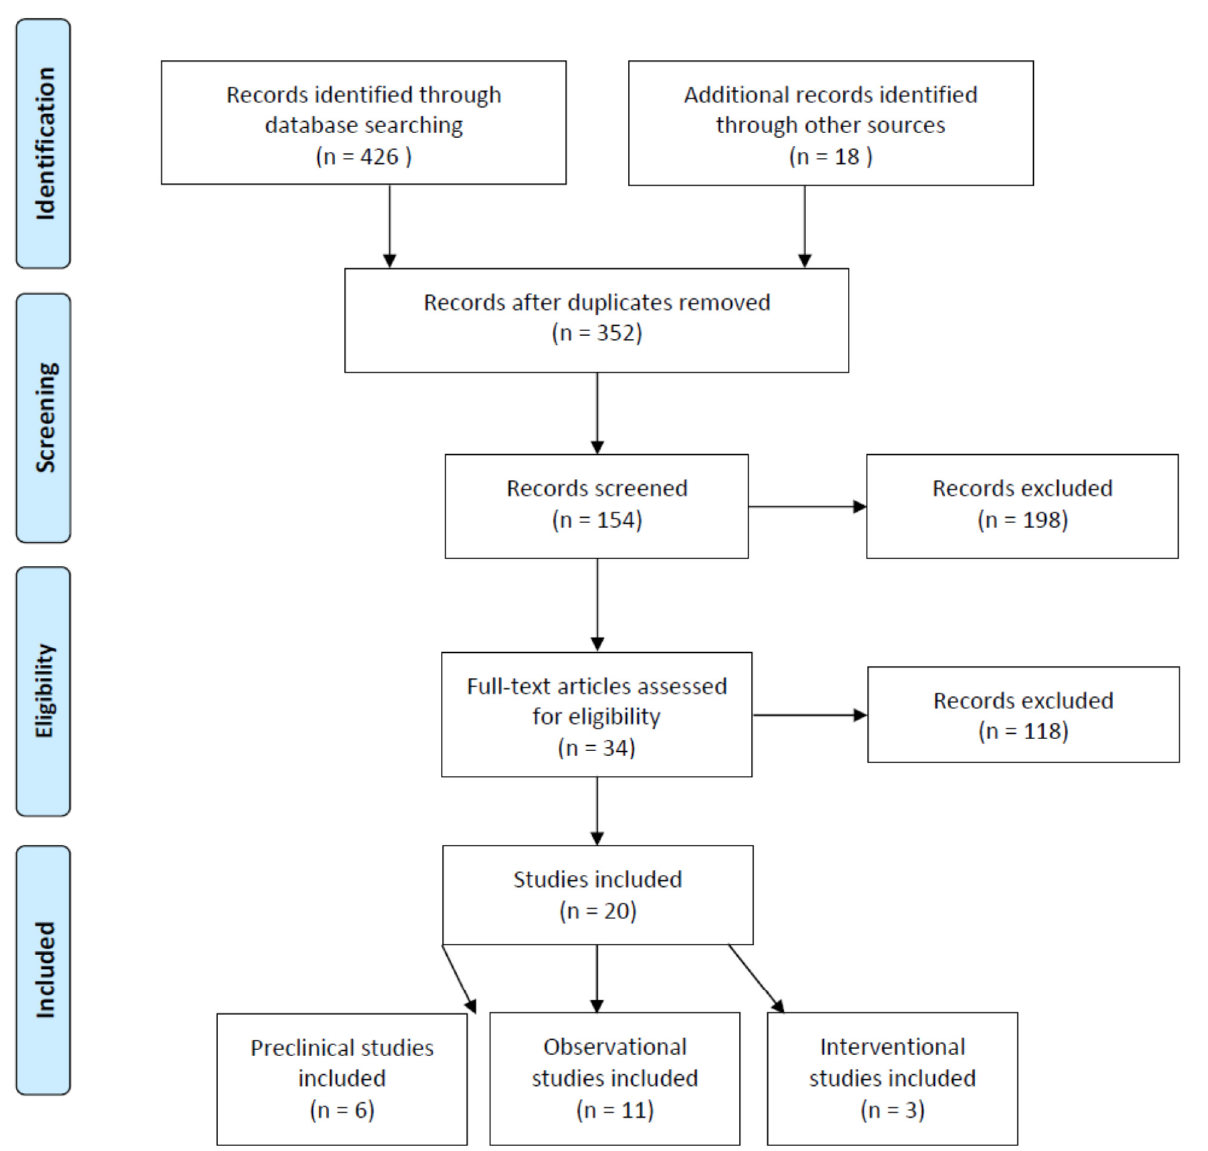
Figure 2. PRIMSA flow chart of the systematic review of publications on carotenoids in the management of glaucoma.